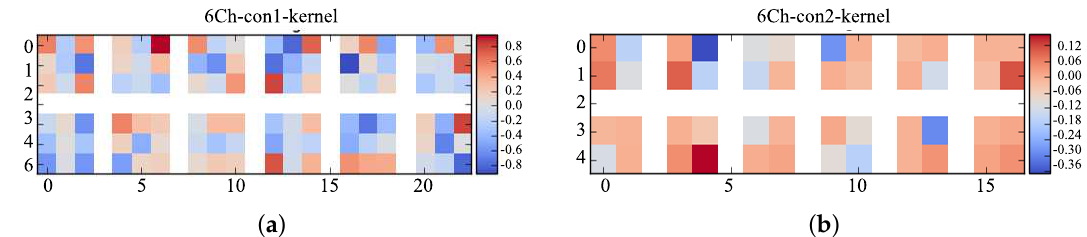
Figure 14. Visualization of the convolution kernel of the 6Ch-CNN: ( a ) visualization of the convolution kernel in the first round of feature extraction; and ( b ) visualization of the convolution kernel in the second round of feature extraction.